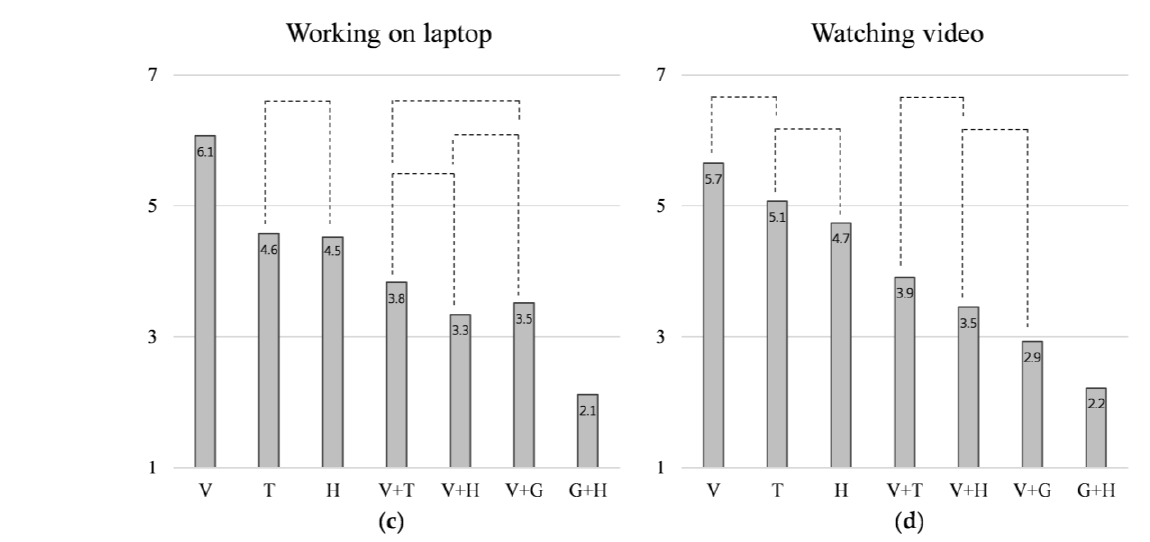
Figure 7. Preference scores for the seven input interactions in the four NDRTs: ( a ) relaxing, ( b ) eating, ( c ) working on laptop, and ( d ) watching video.